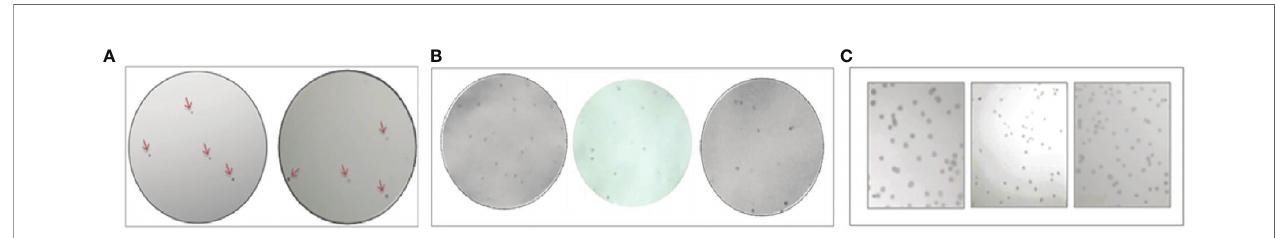
FIGURE 2 | DNA library screening against rabbit polyclonal antiserum. (A) Primary screening in duplicates, arrow mark indicates the prominent spots developed. The positive plaques appeared as “ doughnuts ” with clear centers, (B) Secondary screening and (C) Tertiary screening (ED-BDU1 l 1-1 III, ED-BDU1 l 3-1 III, and ED-BDU1 l 5-1 III).